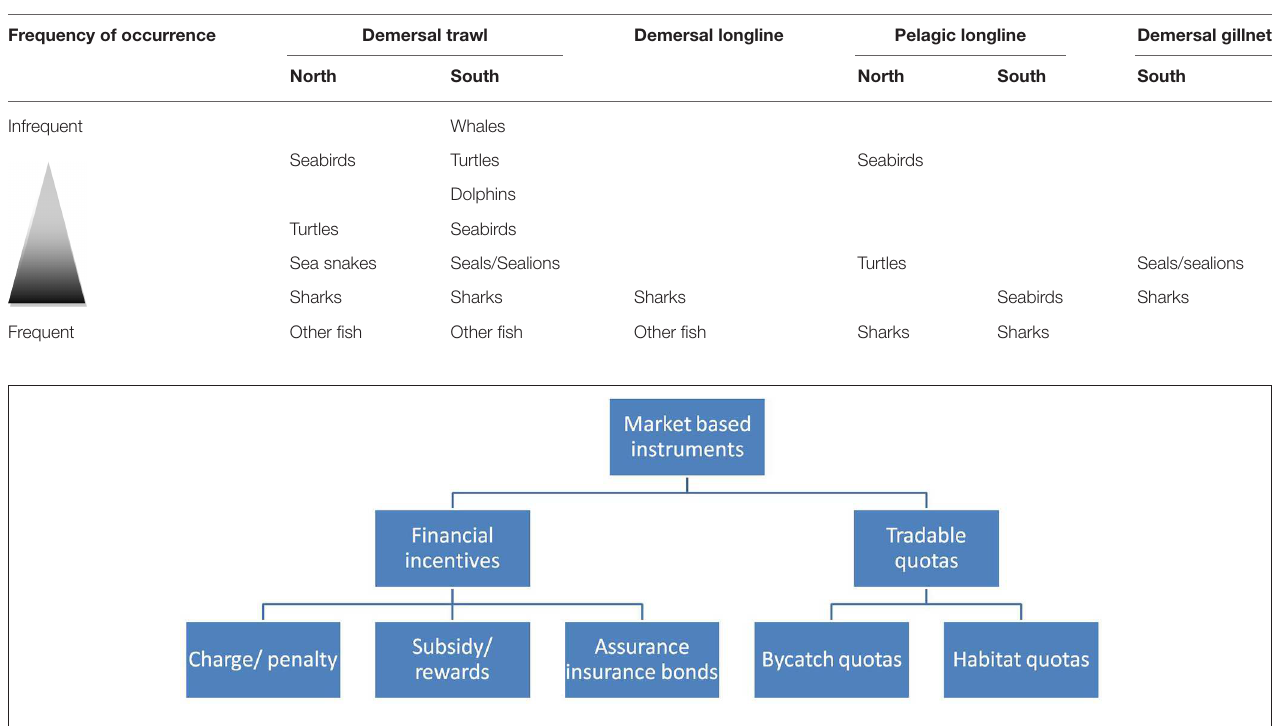
TABLE 1 | Examples of how the frequency of non-commercial bycatch can vary by gear type and region in some Australian fisheries 6 .